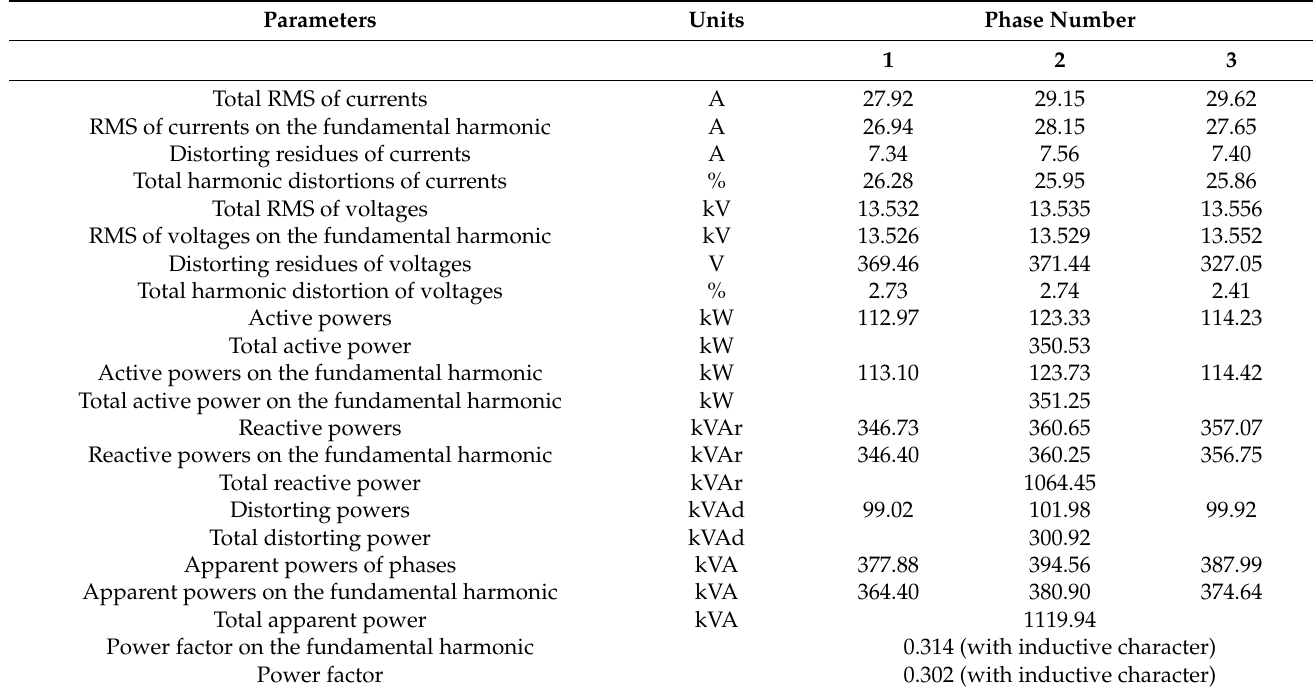
Table 4. Power quality indices, powers and power factors using FFT and the first theory for the second case